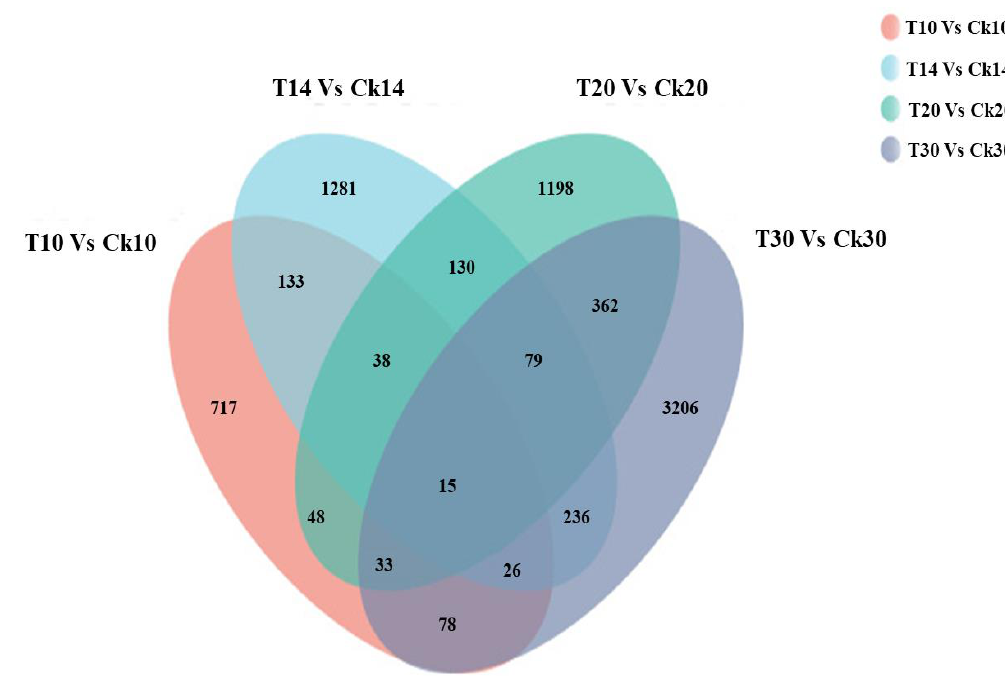
Figure 3. Venn diagram showing the number of common and unique DEGs among four colored group samples. Dark gray group shows the highest number of DEGs and shares more DEGs with the other three groups in comparison to red, blue, and green groups.